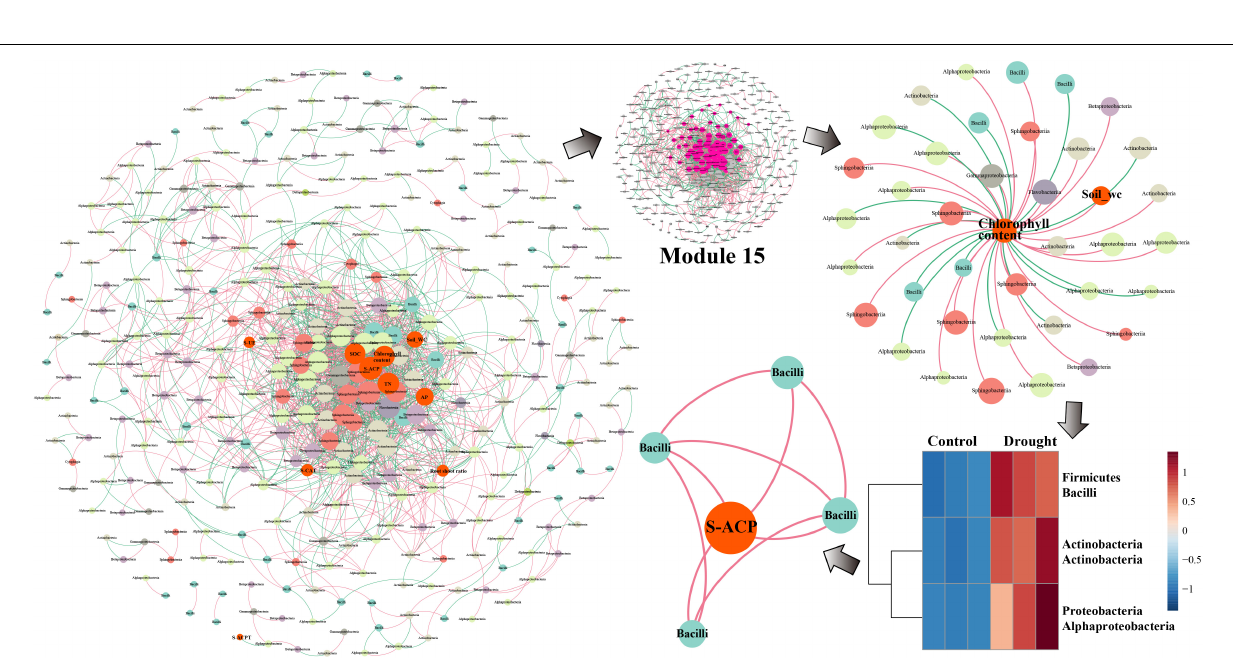
FIGURE 6 | Network analysis of MENA, the analysis shows that there are different degrees of association between the bacterial communities of rhizosphere of sugarcane variety ZZ9. The nodes represent the bacteria OUT that have significant interaction in the microbial network, the size of which is determined by the degree of connection, and they are classified according to the system level. The relationship is colored. The red line connecting the nodes indicates positive interaction, and the green line indicates negative interaction. The rhizosphere bacterial community of the drought-tolerant variety ZZ9 mainly relies on the Bacilli flora (PGPR) to respond to drought stress. S-ACP is closely